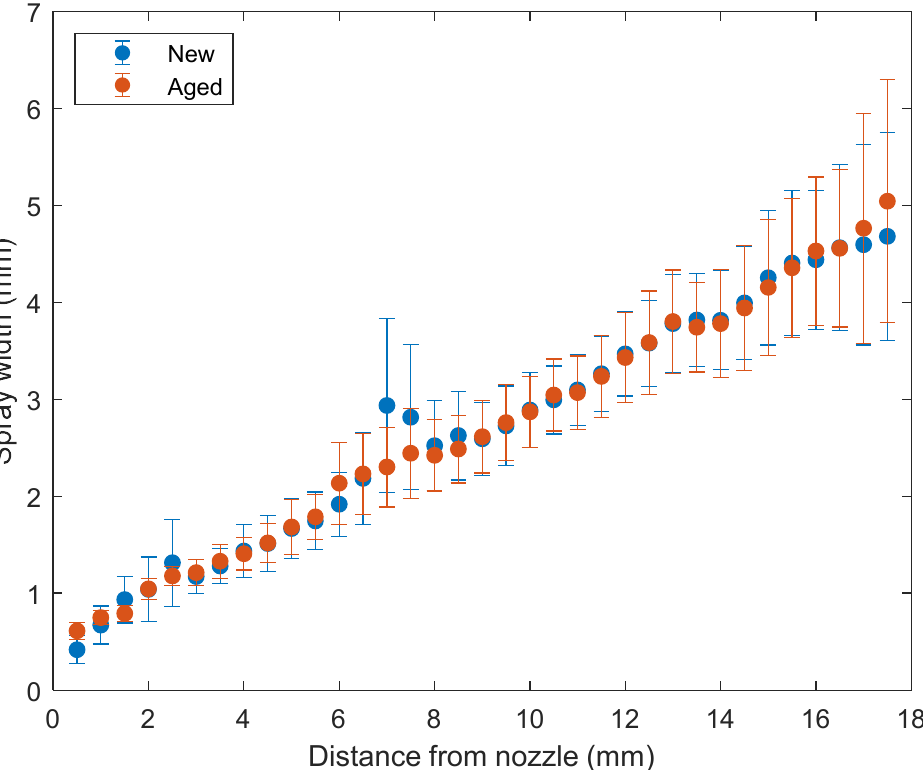
Figure 15. Spray width comparison at low load when using the new and the aged injector.